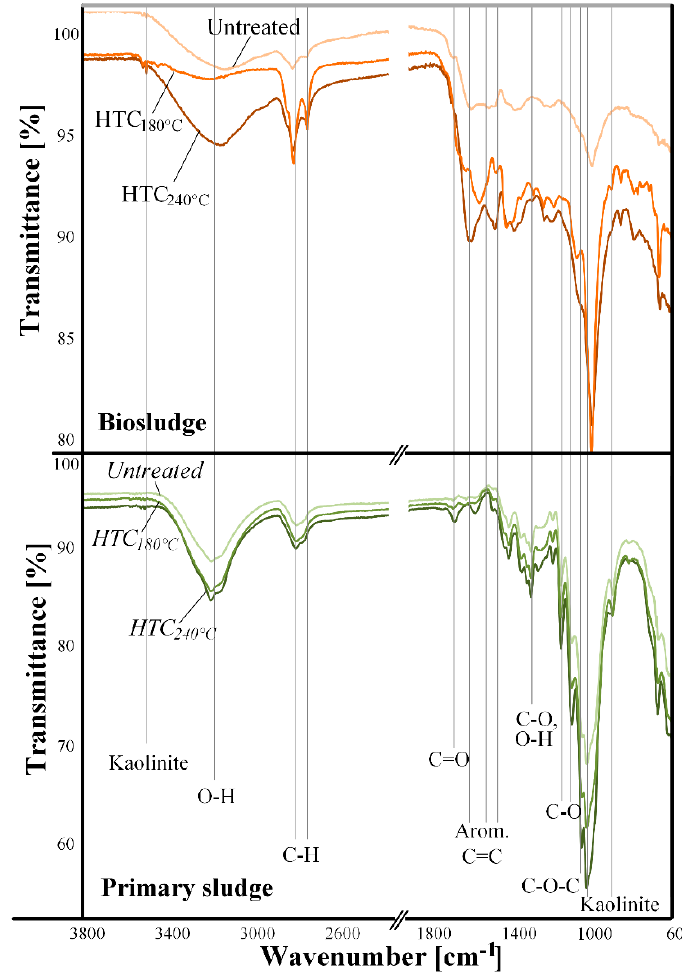
Figure 7. FTIR spectra of the HTC180 °C and HTC240 °C, including feedstocks of primary sludge and biosludge.